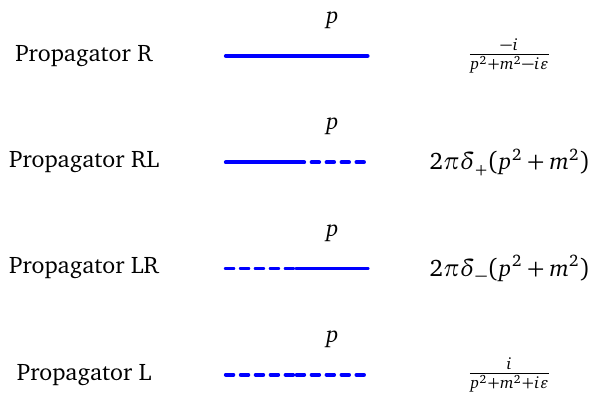
Figure 10: k -OTO propagator for a free scalar theory. Here, δ ± are the usual mass ) as given in shell delta functions with θ ( ± p 0